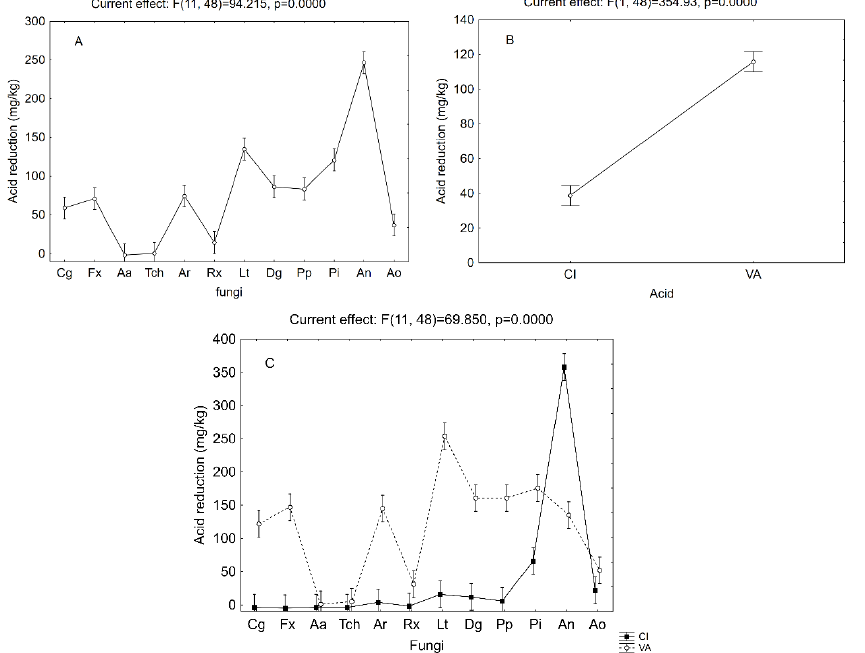
Figure 2. Effective hypothesis decomposition of MANOVA on the decrease in the acids (mg/kg). Effects of fungi species (for abbreviations, see Table 1) on ( A ) acid vs. pH ( B ) and fungi vs. acid ( C ) (CI, cinnamic; VA, vanillic acid). Vertical bars indicate 95% confidence intervals. The F-test and relative degrees of freedom are given at the top of each panel. Contr., liquid medium without fungi.